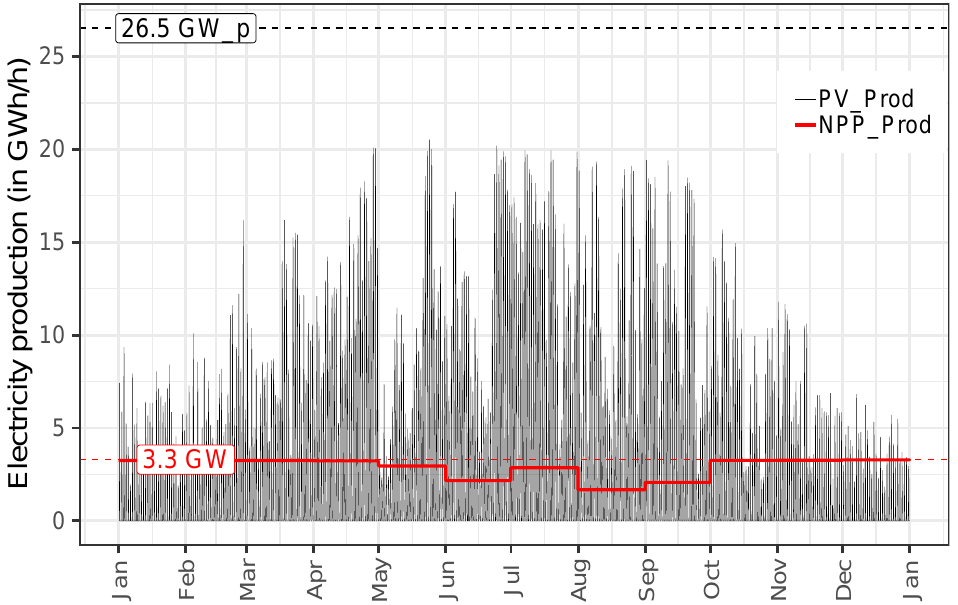
Figure 10. Hourly photovoltaics (PV) and nuclear power plant (NPP) production profiles “PV_Prod” and “NPP_Prod” (see Table 1) for 2010 at an installed PV peak capacity of 26.5 GW p (950 full load hours) derived from meteorological satellite-data reanalysis of Pfenninger and Staffell [60] and the monthly averaged NPP production at an installed capacity of 3.3 GW of BFE [53] for an annual total of 25 TWh